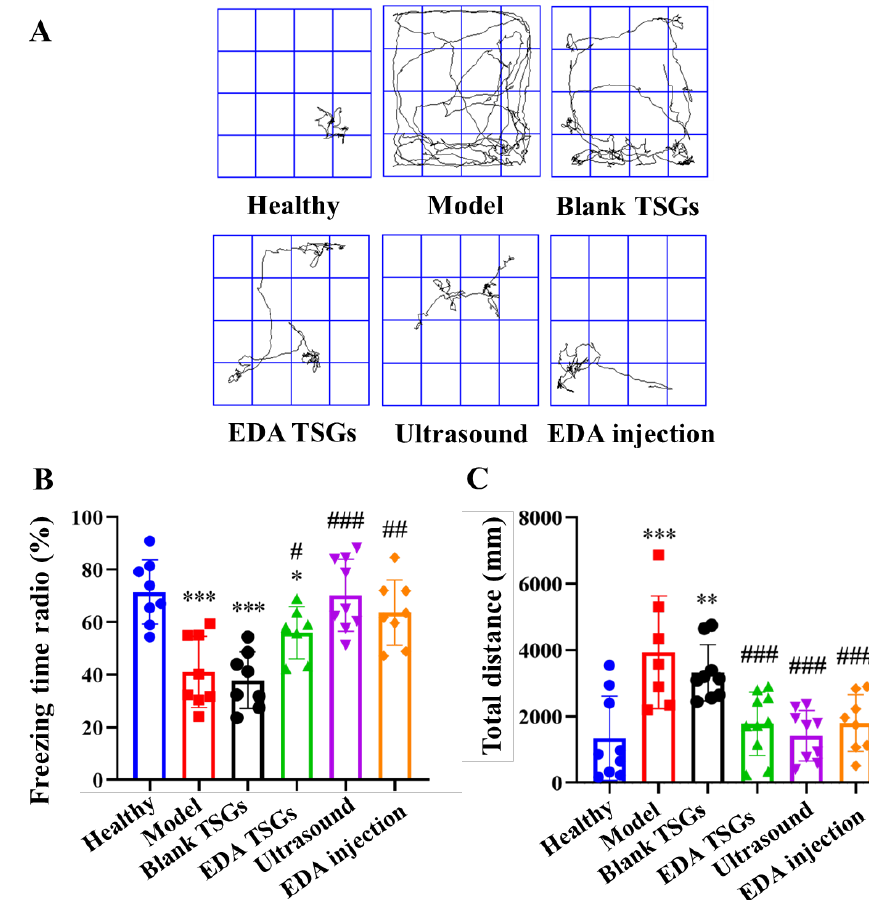
Figure 10. Comparison of reflex to conditional memory of mice in each group by the fear conditioning test. The track map ( A ); Statistical data analysis of the freezing time radio ( B ) and total distance ( C ). Data are represented as mean ± SD ( n = 10). * : means significant difference, vs. the healthy group, * p < 0.05, ** p < 0.01, *** p < 0.001; # : means significant difference, vs. the model group, # p < 0.05, ## p < 0.01, ### p < 0.001.